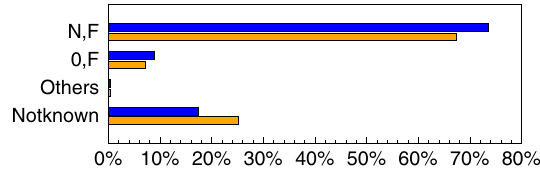
Figure 1. Target nuclides cited in the evaluation summaries of ENDF / B-VI [11] and UKFY3.0 [12]. Orange and blue bars rep- resent percentages of target nuclides in Ref. [11] and Ref. [12], respectively. ”Others” is the total of other actinides. For ref- erences with no nuclide or reaction information in CINDA are categorised as ”Notknown”.